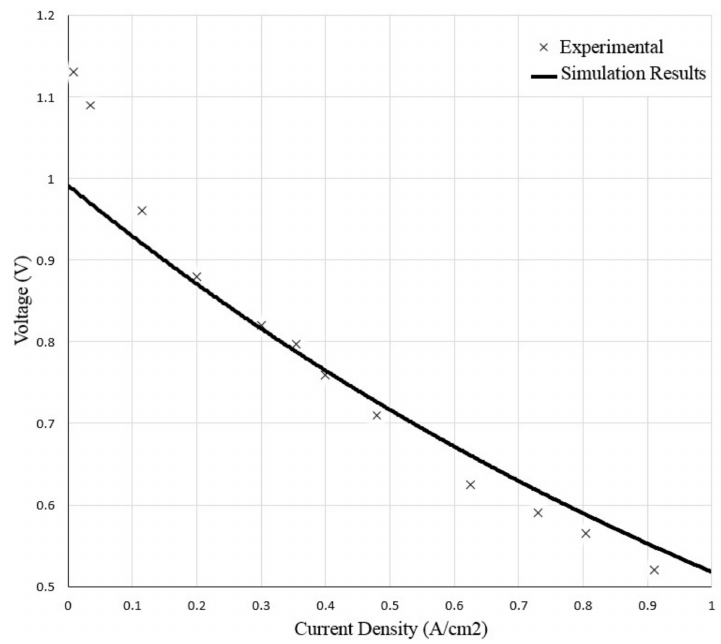
Figure 6. Comparison of current-voltage polarization curve of